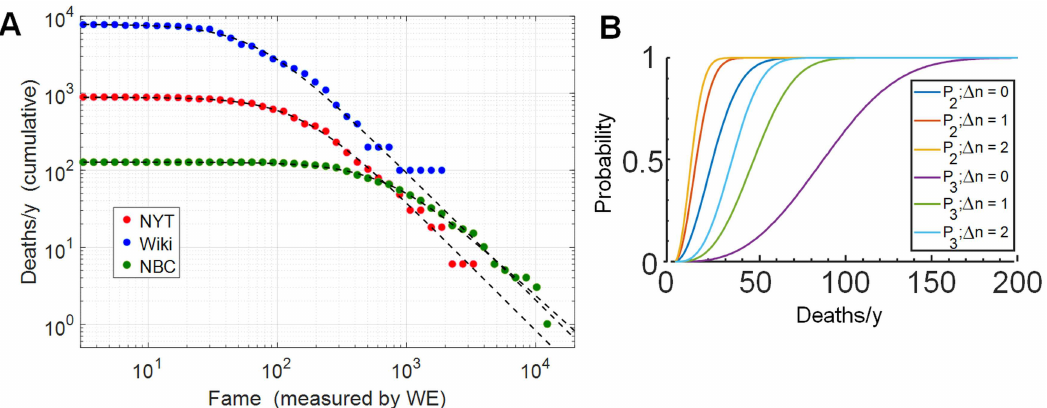
Fig 6. Cumulative frequency of deaths versus fame. (A) Cumulative frequency (Gutenberg-Richter) plot of reported deaths versus fame. For each degree of fame (as measured by WE ), the plot shows the annualized rate at which deaths of equal or greater fame occur. Green, red, and blue symbols indicate the NBC, NYT (1 & 2)and Wiki datasets respectively. Dashed curves show least squares fit to Gutenberg-Richter expression, Eq 6, giving ν = 1.5 − 1.7 (Table 2). (B) Date overlap (birthday-problem) probability versus death rate. Each curve gives the probability P that, if the indicated number of deaths occur at random during one year, there will be at least one instance where two ( P 2 ) or three ( P 3 ) of those deaths are separated by only Δ n days.